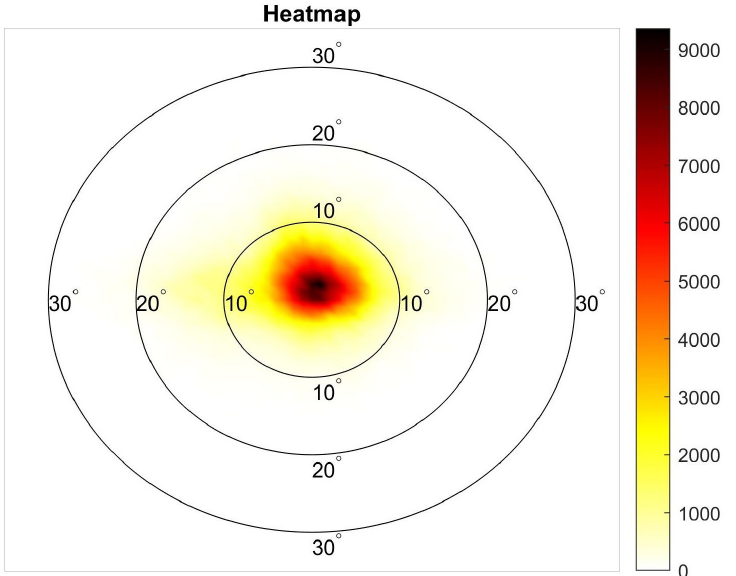
Figure 15. Heatmap of the visual field for user gaze combined for all sessions performed. The circles are centered at the center of the HMD screen and indicate the visual angle (e.g., the 10° circle represents the central 20° of visual eccentricity). The colors represent how frequent the user fixated at that particular location on the HMD screen with white representing 0 and black representing